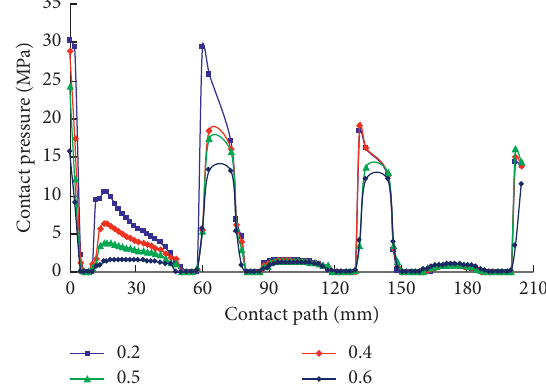
Figure 12: Change curves of contact pressure under different friction